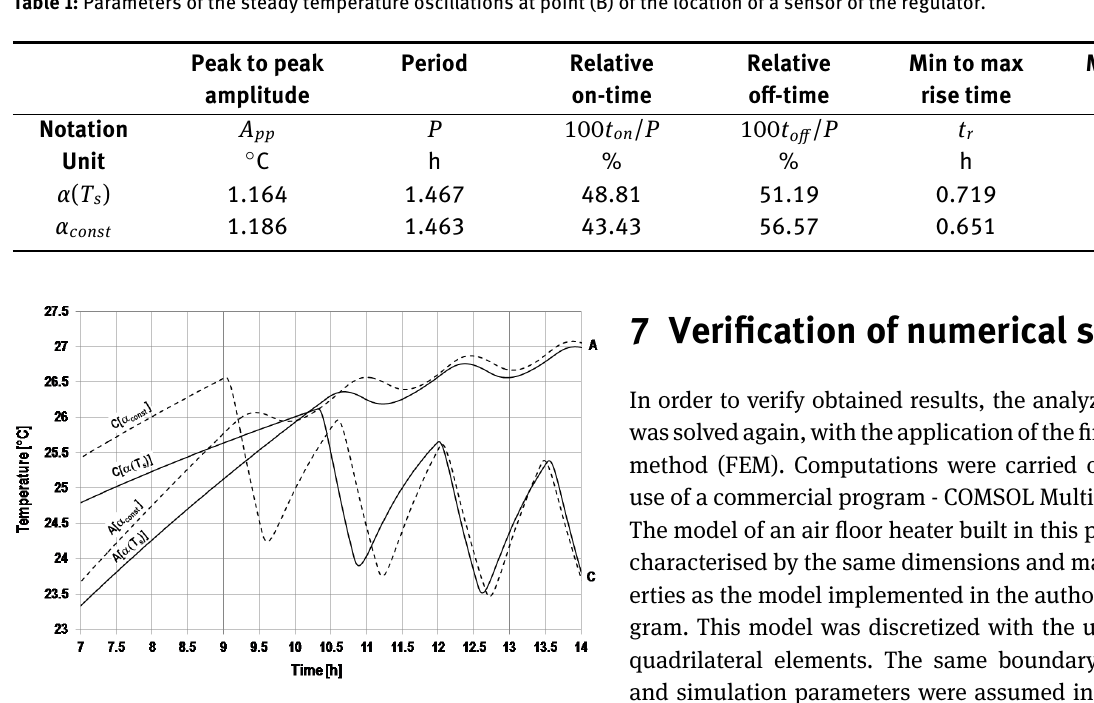
Figure 9: Temperature profiles at points A and C of the model of a floor heater with variable α ( T s ) and constant heat transfer coefl- cient α const .